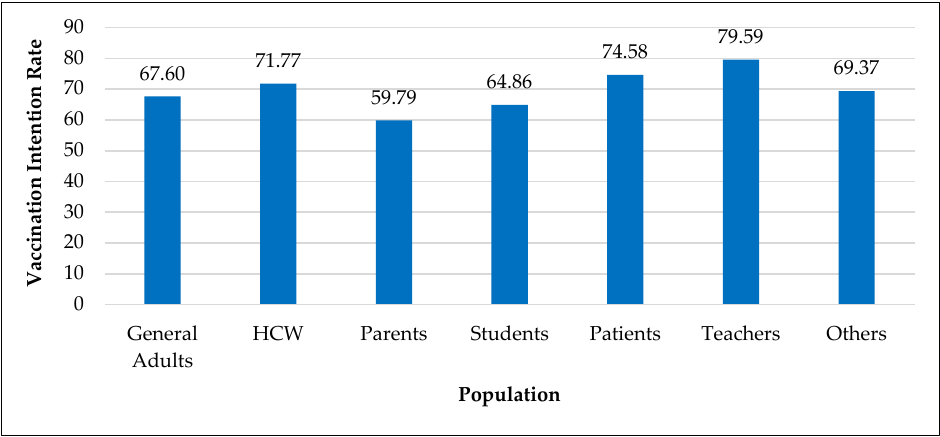
Figure 2. Vaccination intention rate by population.